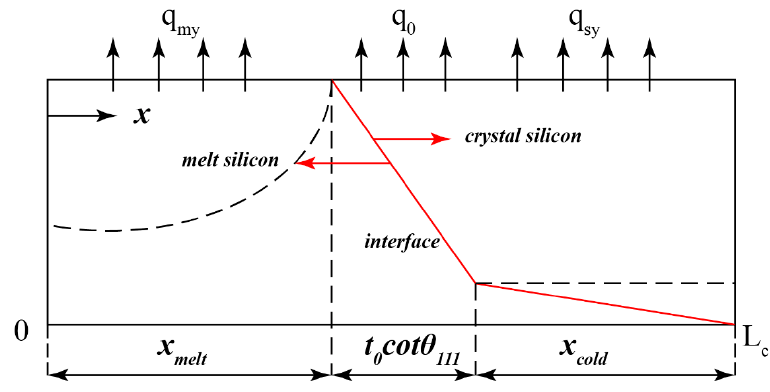
Figure 4 . Mathematic model of both solid and melt part. Figure 4. Mathematic model of both solid and melt part. Table 1. Furnace heat transfer parameters and material properties used in all calculations. Table 1. Furnace heat transfer parameters and material properties used in all